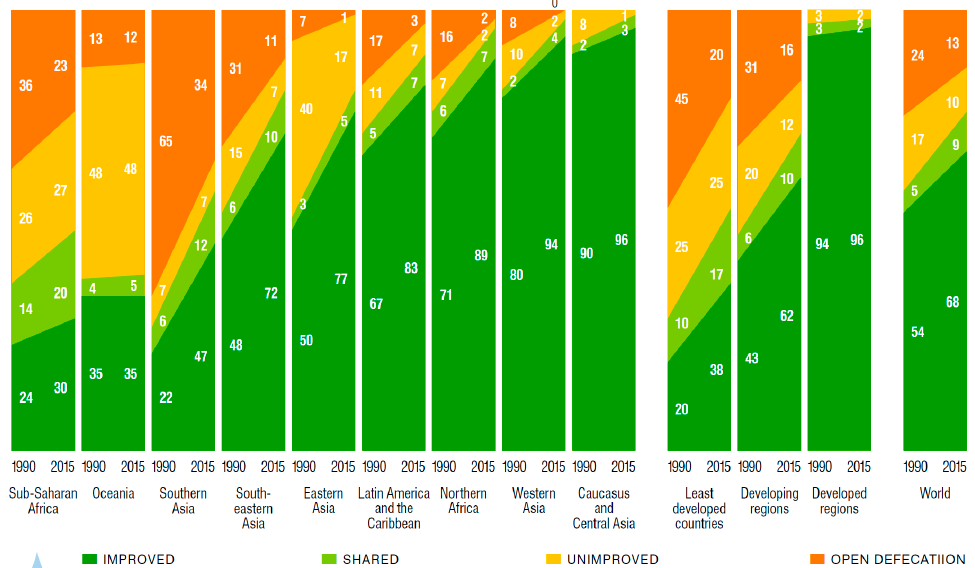
Figure 2. Sanitation coverage trends by developing regions and the world, using the JMP improved